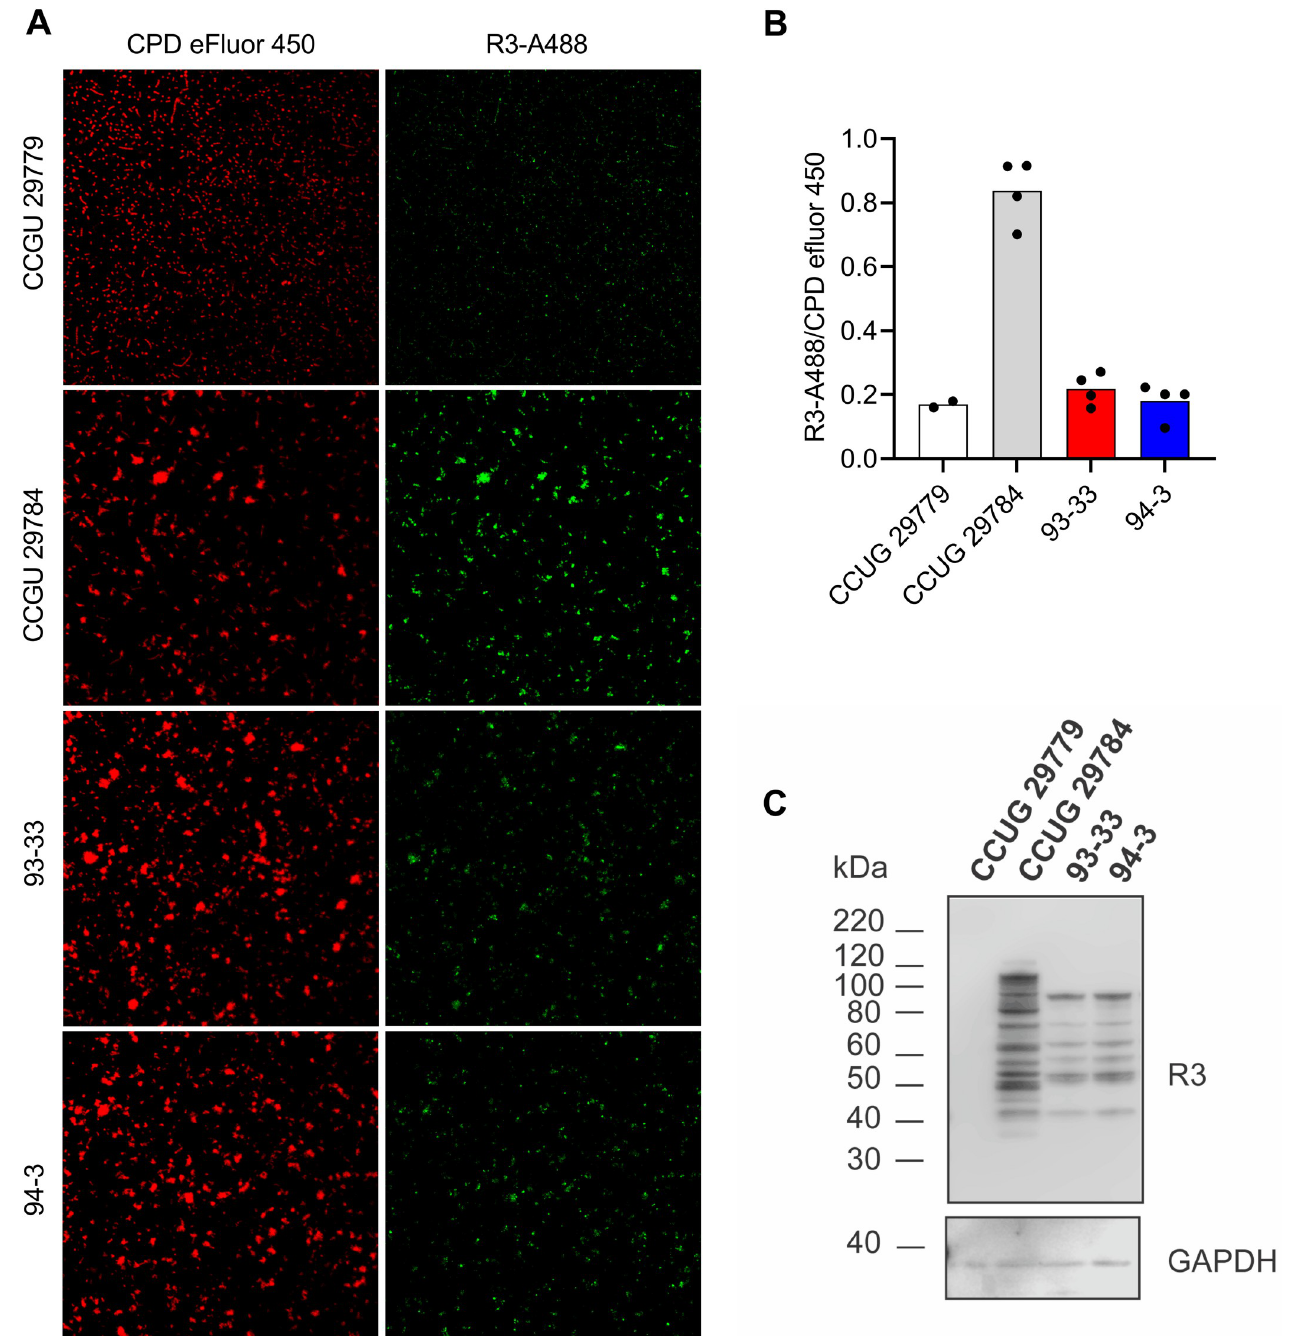
Fig 1. (A) Visualization of the R3 antigen at the cell surface of strains 93–33, 94–3, CCUG 29779 (negative control) and CCUG 29784 (positive control) by confocal microscopy and direct antibody staining using α -R3 as primary antibody and Alexa Fluor 488 as secondary antibody (green). Proteins in general (protein N termini and lysine residues) were labeled with CPD-eFluor 450 and used as internal normalization control (red). (B) Quantification of the R3-Alexa 488 signal relative to the CPD eFluor 450 signal. (C) Western blot analysis of GBS whole cell denatured lysates from strains 93–33, 94–3, CCUG 29779 (negative control) and CCUG 29784 (positive control). The blots were probed with α -R3 antibody (upper panel) and α -GAPDH antibody as an internal loading control (lower panel). The protein standards are shown to the left of the blots. Raw data images of western blots are found in S1 Raw images.